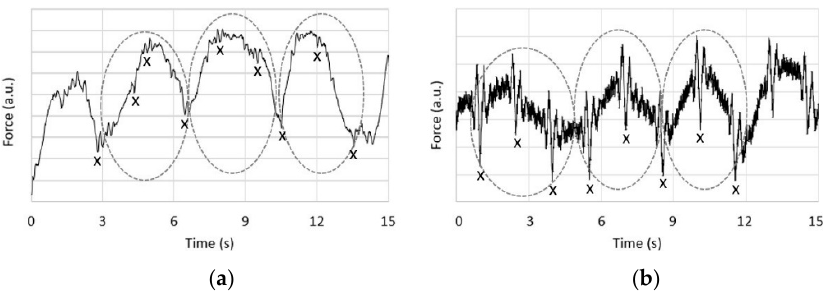
Figure 3. Measured BCG from a patient in a supine posture with the sensor located ( a ) below the mattress and ( b ) head of the mattress, respiration and cardiac cycles are marked by circles and “x” in the figures,